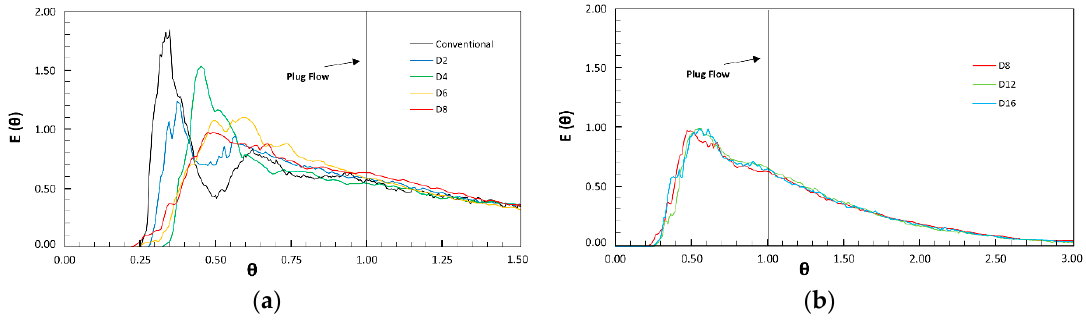
Figure 5. Residence time distribution (RTD) curves of ( a ) conventional, D2, D4, D6 and D8 designs and ( b ) from D8 to D16 models.